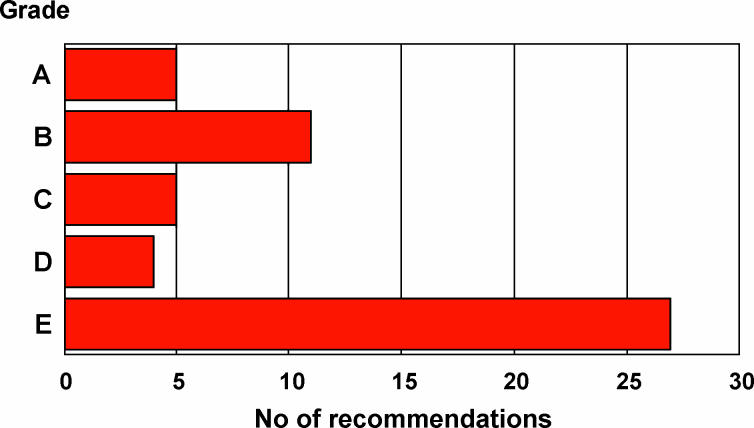
Number of Recommendations of Each Grade of Evidence in the Surviving Sepsis Campaign GuidelinesThe figure shows that there are more E-grade recommendations than all the other grades put together. Grading system: A, supported by at least two large randomized trials with clear results; B, supported by a large randomized trial with clear results; C, supported by small randomized trial(s) with uncertain results; D, supported by a study with nonrandomized contemporaneous controls; E, studies with historical controls, uncontrolled studies, case series, and expert opinion.